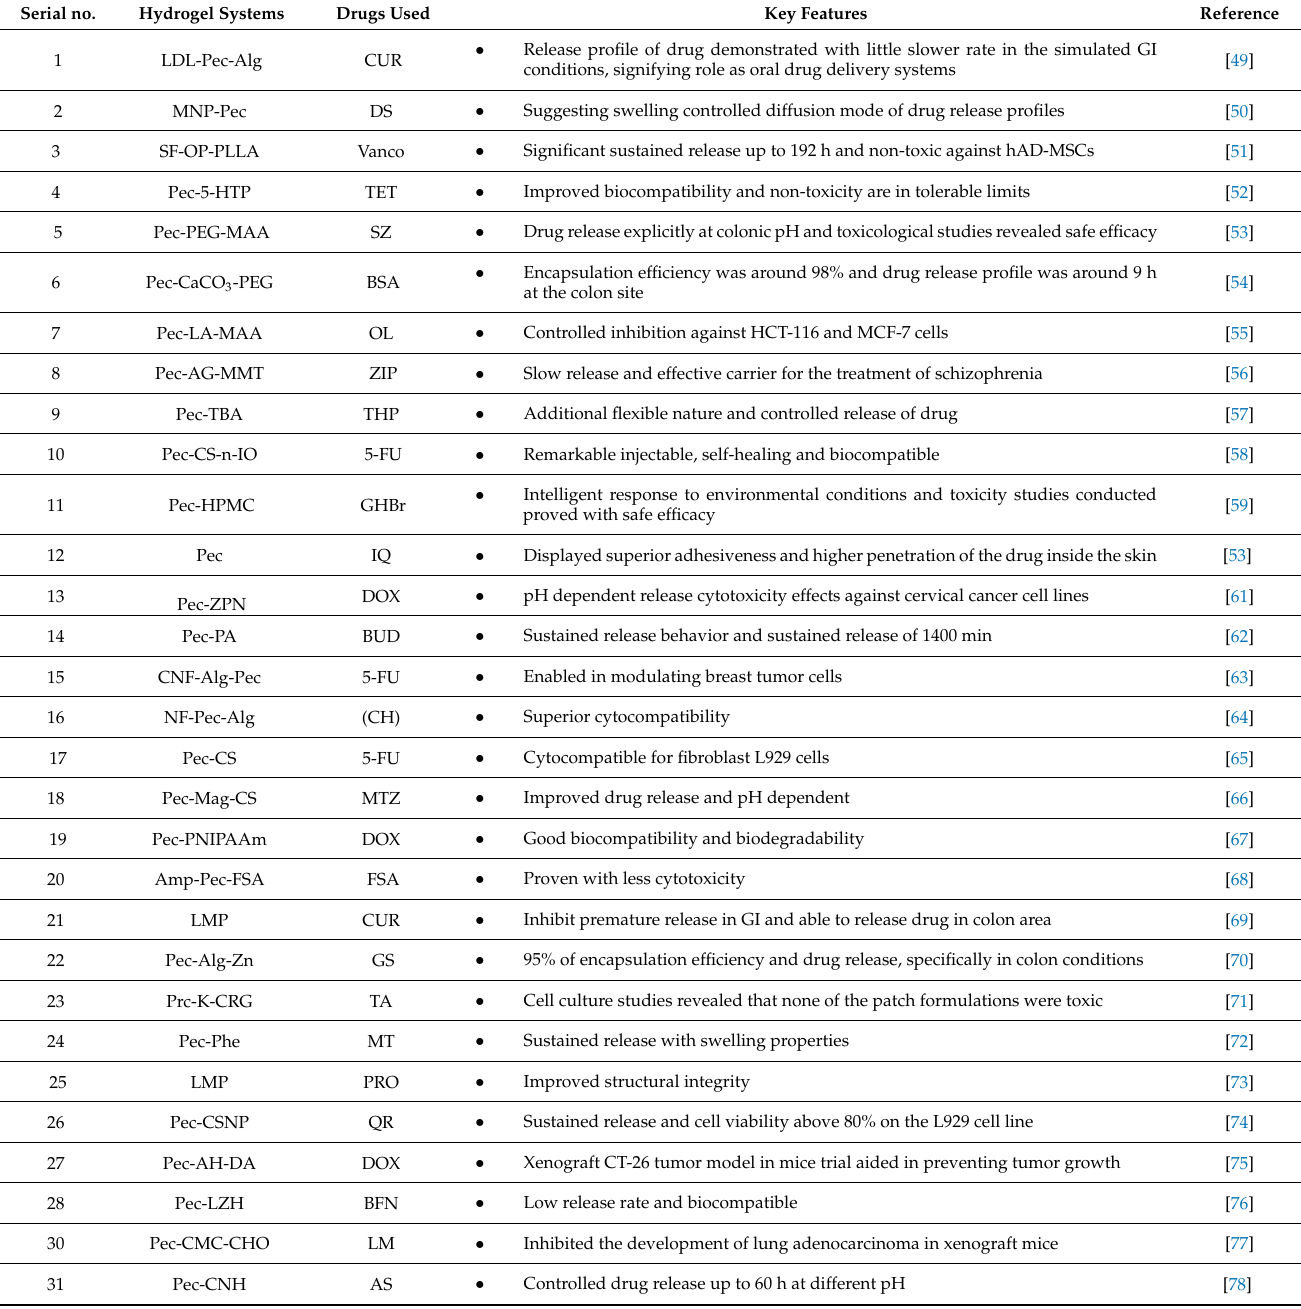
Table 1. Summary of various types of Pec-based hydrogel systems, drugs used and their key features. Key Features